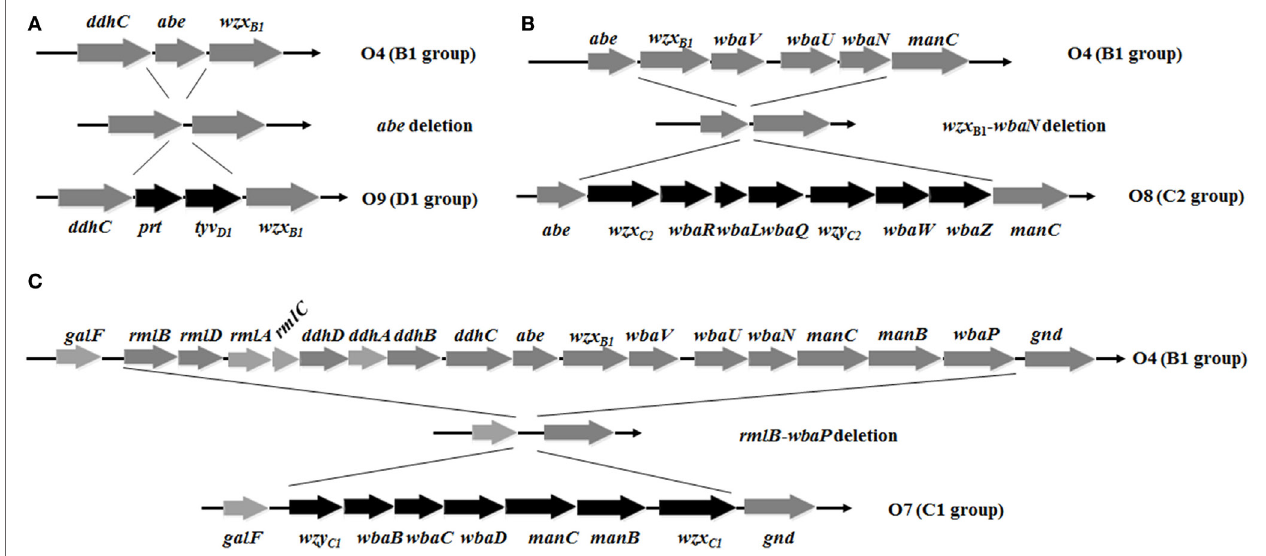
FigUre 1 | Deletion-insertion mutations resulting in O-serotype conversion in Salmonella Typhimurium. (a) The abe gene was deleted and inserted by prt - tyv D1 from S . Enteritidis, converting the O4 serotype to O9. (B) Genes wzx B1 , wbaV , wbaU , and wbaN were deleted and inserted by wzx C2 , wbaR , wbaL , wbaQ , wzy C2 , wbaW , and wbaZ from S . Newport, converting the O4 serotype to O8. (c) The entire O-antigen gene cluster of S. Typhimurium was deleted and inserted by the C1 serogroup O-antigen gene cluster from S . Choleraesuis, converting the O4 serotype to O7. Genes inserted into the S. Typhimurium O-antigen gene cluster for O-serotype conversion are indicated by black arrows and native genes are depicted as gray arrows. Diagrams were drawn to